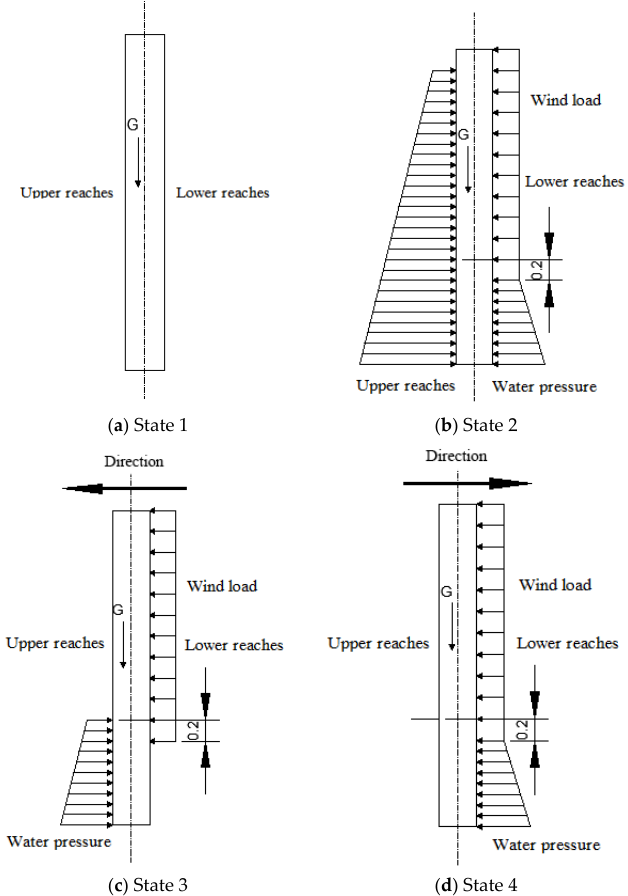
Figure 1. ( a – d ) Stress analysis of gate under different operating conditions.